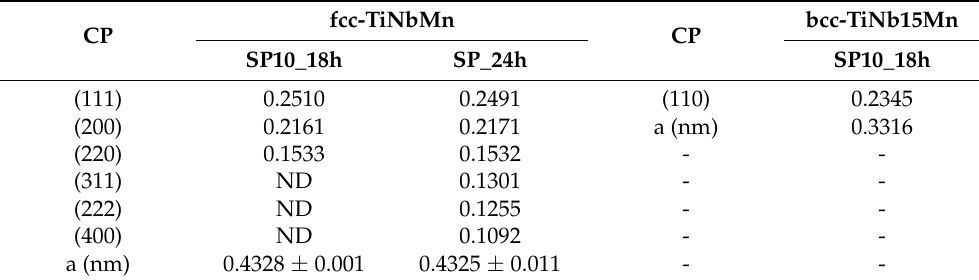
Table 2. Interplanar distances and the corresponding lattice parameters (a) determined by HRTEM- FFT for both bcc-TiNb15Mn and fcc-TiNbMn alloys in the SP10_18h and SP10_24h specimens. ND = crystallographic plane not detected; CP = crystallographic